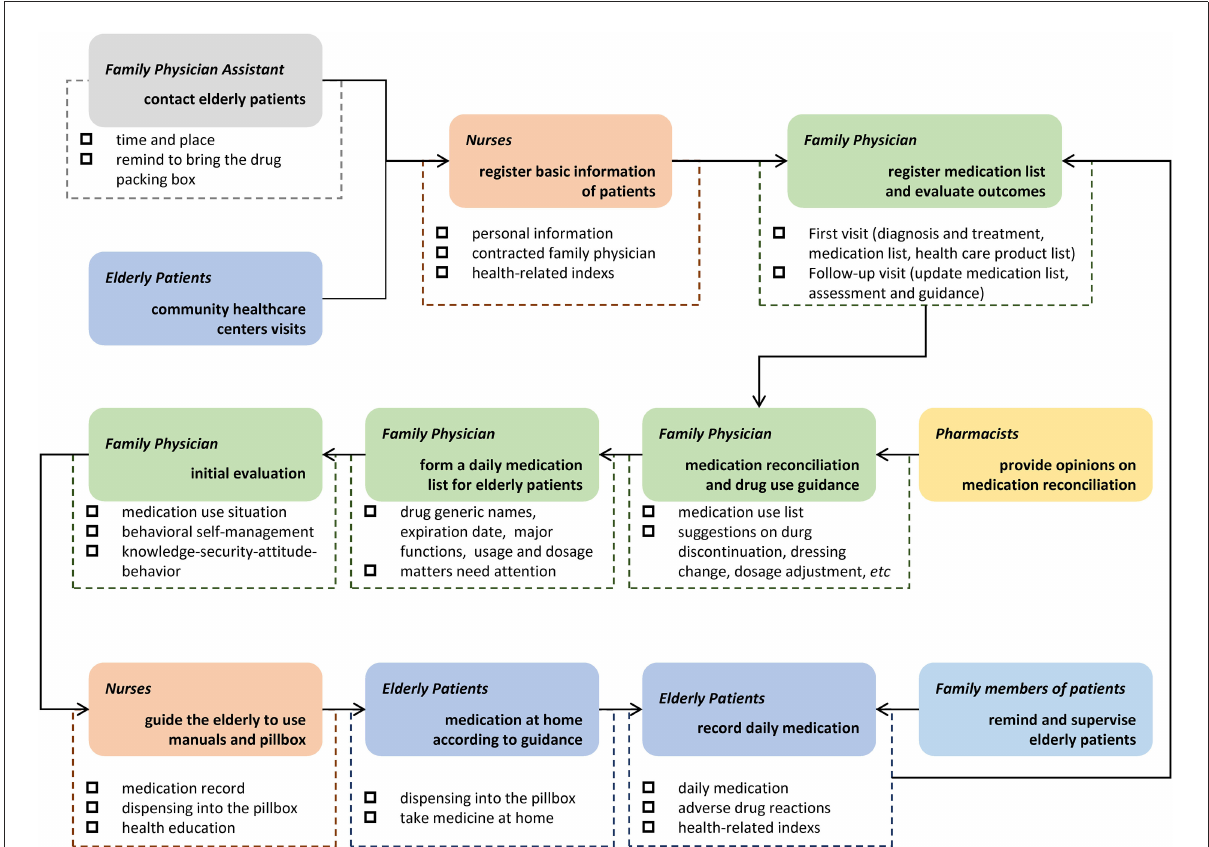
FIGURE1 Operation process of Rational Medication Management Mode. Based on family physician service, the mode in this current study specifically refers to the joint participation of family physicians, pharmacists, family physician assistants, nurses, elderly and their family members to carry out medication reconciliation and drug use guidance through medication management manual and pillbox.